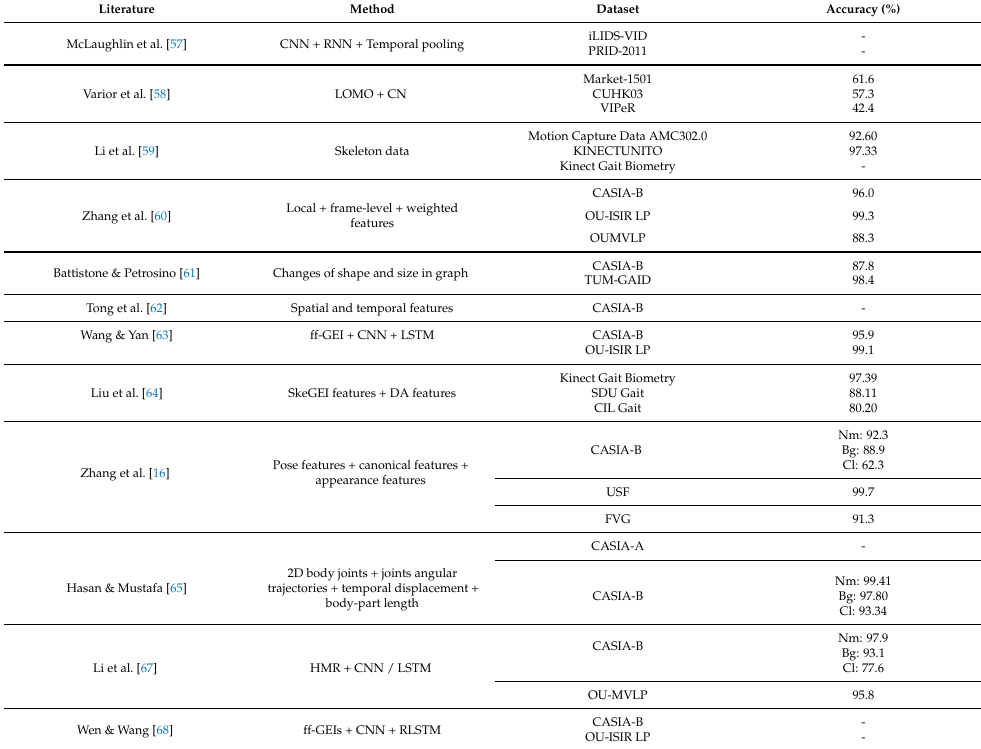
Table 3. Summary of recurrent neural network